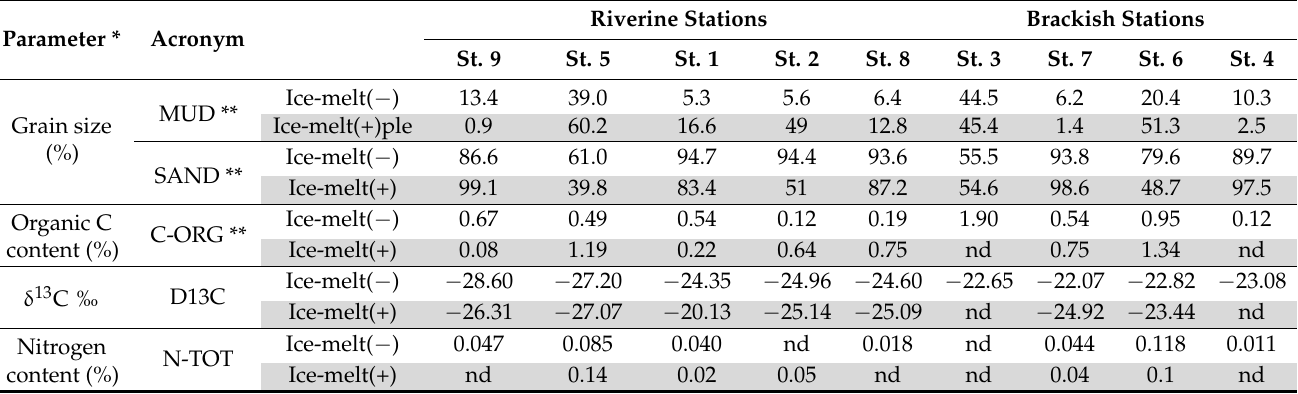
Table 1. Sediment characteristics in Ice-melt( − ) and Ice-melt(+) conditions in the Pasvik